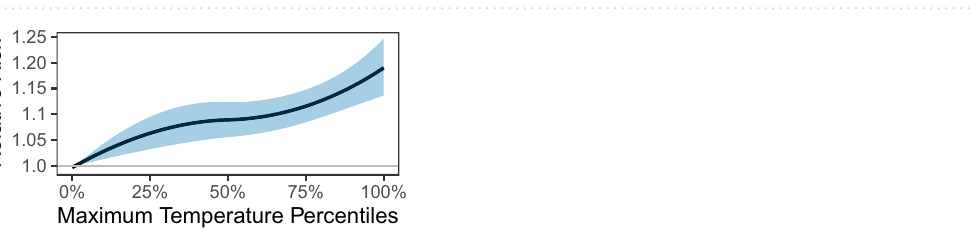
Figure 5. Cumulative exposure–response curve (95% CI shaded in light blue) for the relative risk for Google searches related to maximum ambient temperature percentile over lags 0–5 days. Relative risk on the y-axis is displayed on the log scale. Reference temperature: 1st percentile of DMA-specific daily maximum ambient temperature distribution.